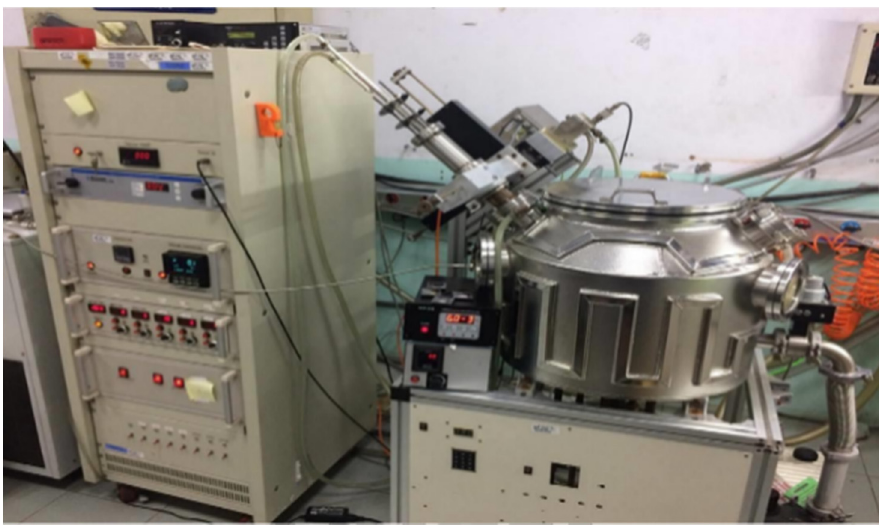
Figure 1. Experimental setup for diamond film fabrication using the microwave plasma jet chemical vapor deposition (MPJCVD) system